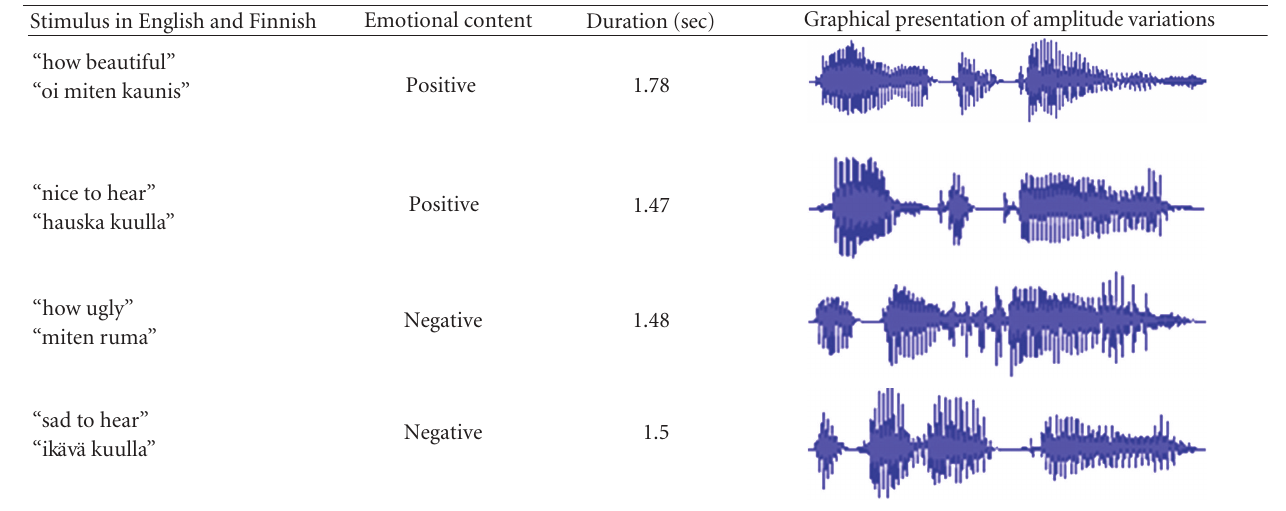
Table 1: The speech samples used in the experiment.